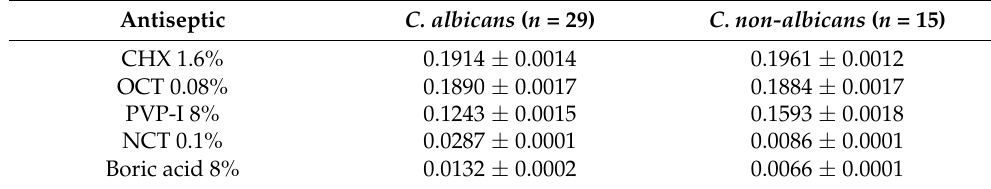
Table 2. Fungicidal activity (BA values) of